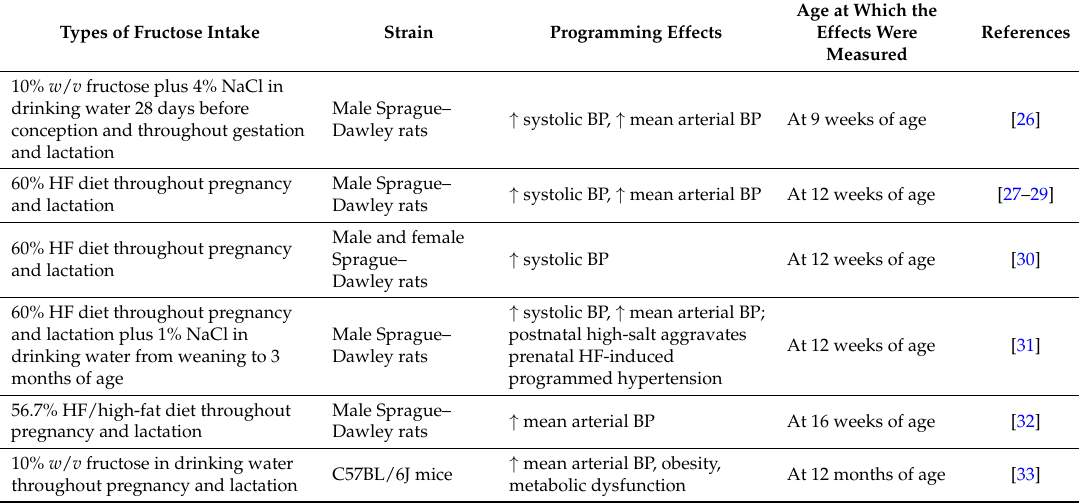
Table 1. Maternal high-fructose (HF) consumption exerts programming effects on blood pressure (BP) in rodent